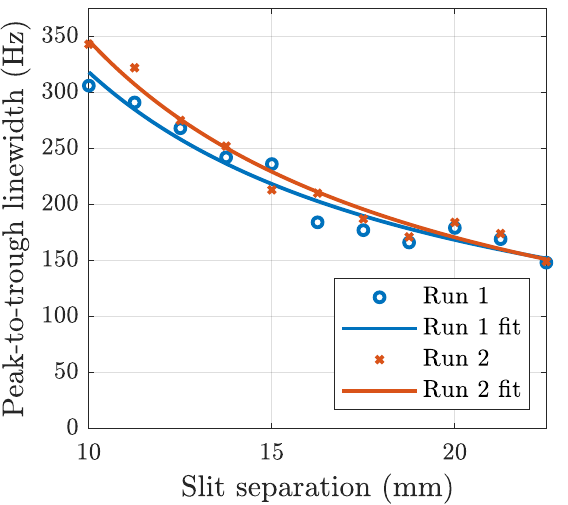
Figure 15. Experimentally measured Ramsey fringe linewidth (frequency difference between the central peak and the adjacent trough) as a function of physical beam spacing for two typical runs. (cid:14) d + c , where A = 2995 Hz ∗ mm, d is the slit spacing, and c = 18.6 Hz The data points are fit to y = A for run 1, with A = 3516 Hz ∗ mm and c = − 5.30 Hz for run